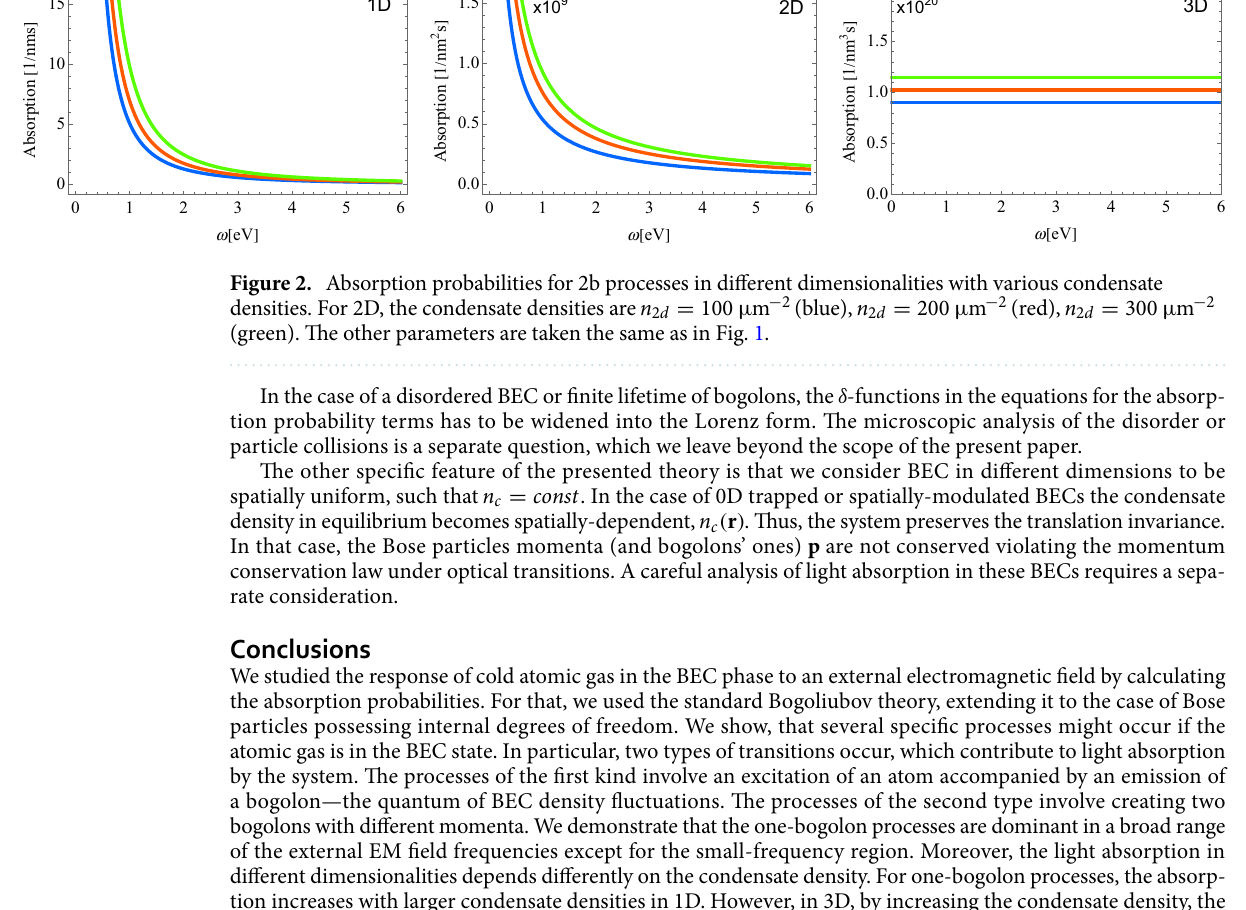
2 2 2 100 µ m 200 µ m 300 µ m (blue), n 2 d (red), n 2 d − − − = = =